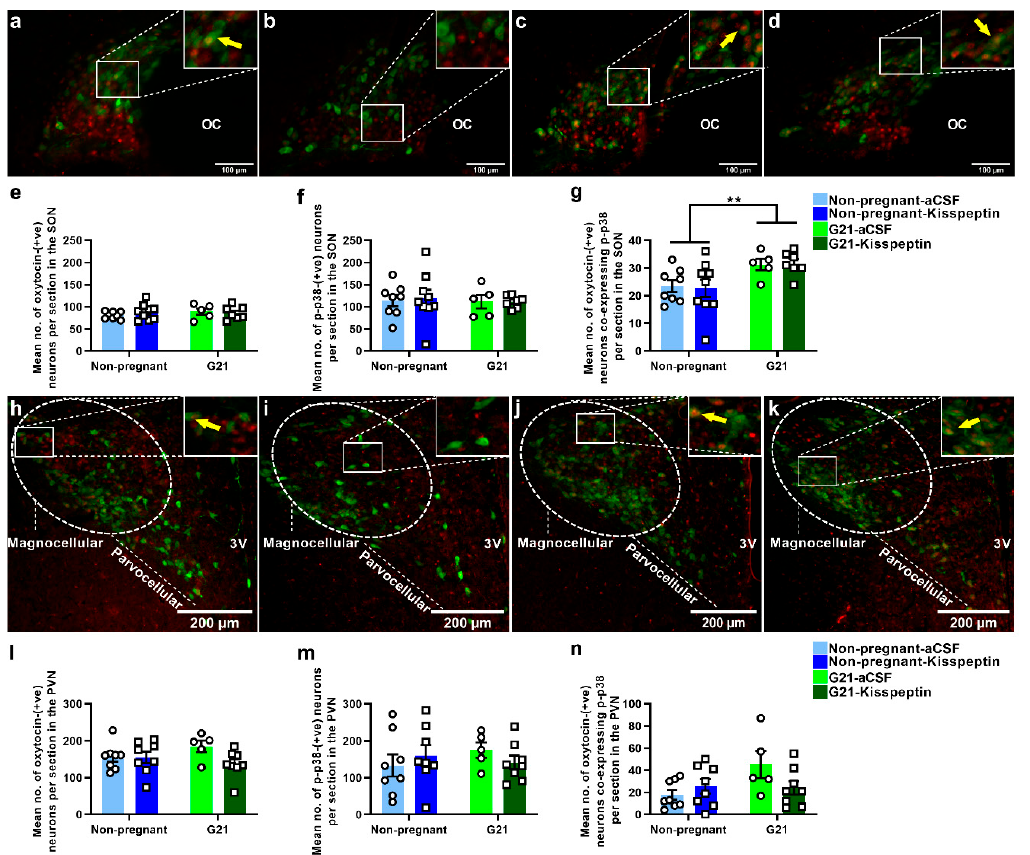
Figure 3. Kisspeptin does not affect p-p38 expression in SON or PVN oxytocin neurons of non- pregnant and G21 rats. Photomicrographs of coronal SON ( a – d ) and PVN ( h – k ) sections showing oxytocin-positive neurons (green) and p-p38-positive neurons (red) in non-pregnant rats ( a , b , h , i ) and G21 rats ( c , d , j , k ) after ICV administration of aCSF ( a , c , h , j ) or kisspeptin (2 µ g in 2 µ L; b , d , i , k ). Yellow arrows point to representative p-p38 and oxytocin co-labelling. Mean (± SEM) number of ( e ) oxytocin-positive neurons (RS: F (1,1) = 0.263, p = 0.612; T: F (1,1) = 0.090, p = 0.765; RS × T: F (1,2) = 0.796, p = 0.380, two-way ANOVA), ( f ) p-p38-positive neurons (RS: F (1,1) = 0.118, p = 0.734; T: F (1,1) = 0.020, p = 0.886; RS × T: F (1,2) = 0.028, p = 0.867, two-way ANOVA) and ( g ) oxytocin-positive neurons co-expressing pERK1/2 (RS: F (1,1) = 9.90, p = 0.004; T: F (1,1) = 0.007, p = 0.930; RS × T: F (1,2) = 0.052, p = 0.821, two-way ANOVA) per section in the SON of non-pregnant rats (aCSF-treated, n = 8, kisspeptin-